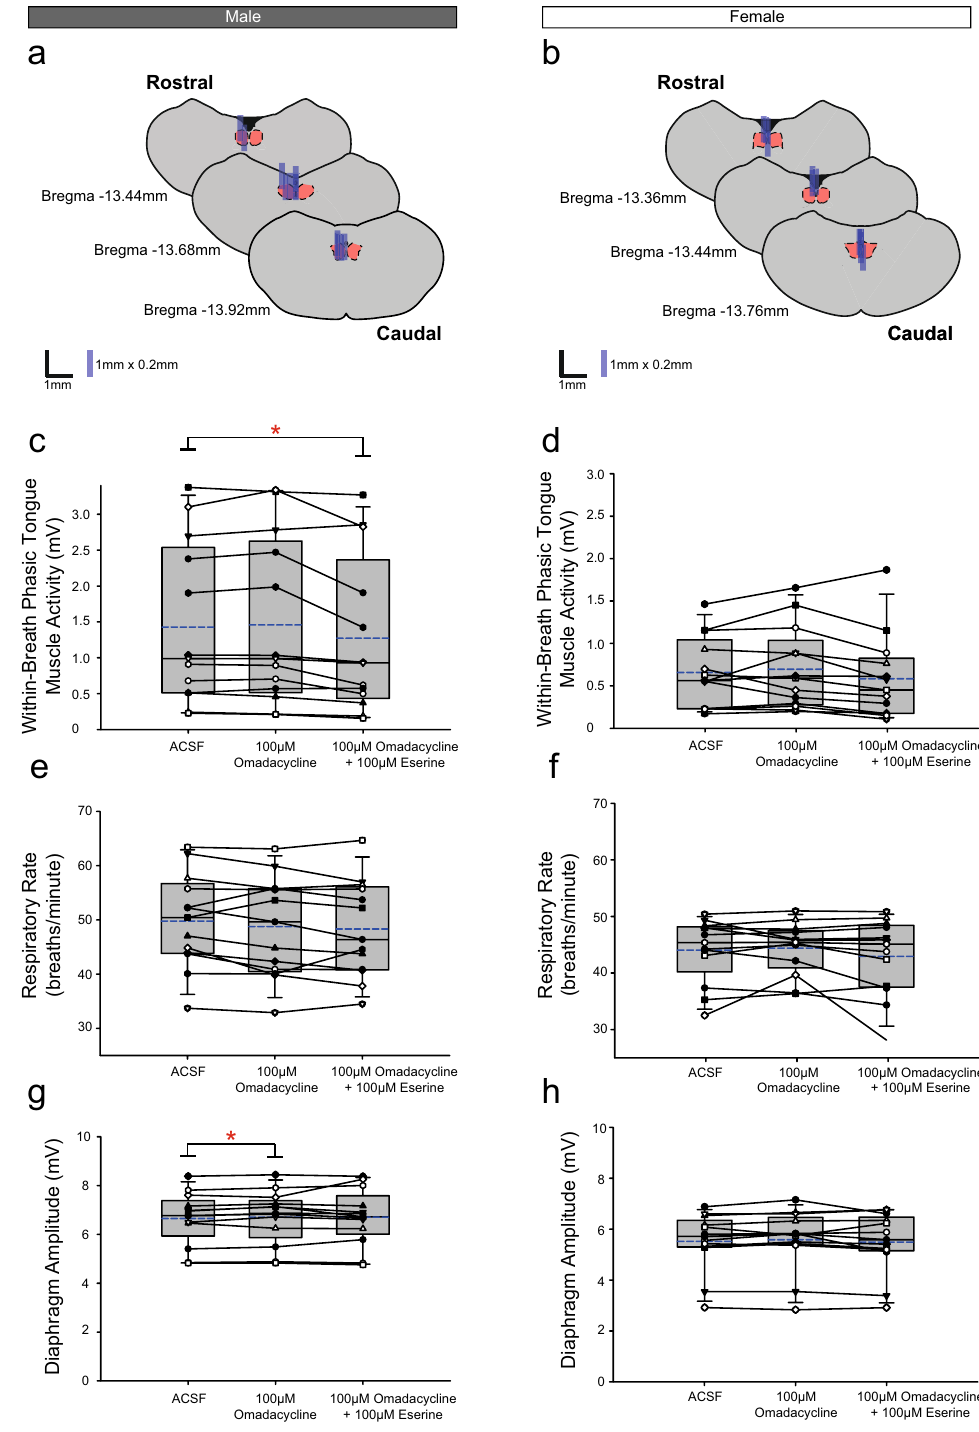
Figure 6. Group data from Protocol 1.2c : Microperfusion of 100 μM omadacycline into the HMN with and without co-application of eserine (left column: male, n = 13; right column: female, n = 13). Schematic representations of coronal sections of medulla illustrating the distribution of probe sites across all experiments ( a , b ). Drawn to scale, the blue rectangles represent reconstruction of the sites of the microdialysis probes; overlap obscures some of the individual probe sites. Box and whisker plots show individual and group data (median [dashed line], mean [solid line] and 25th and 75th percentiles) for within-breath phasic tongue muscle activity ( c , d ), respiratory rate ( e , f ), and diaphragm amplitude ( g , h ). Each animal is indicated by a different symbol. *, indicates p < 0.05 compared to baseline ACSF